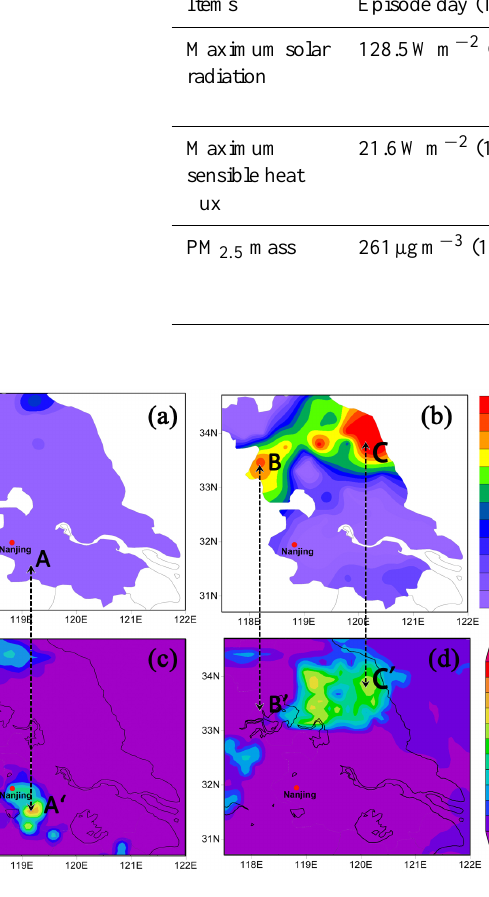
Fig. 7. A comparison of observed and WRF-simulated amounts of